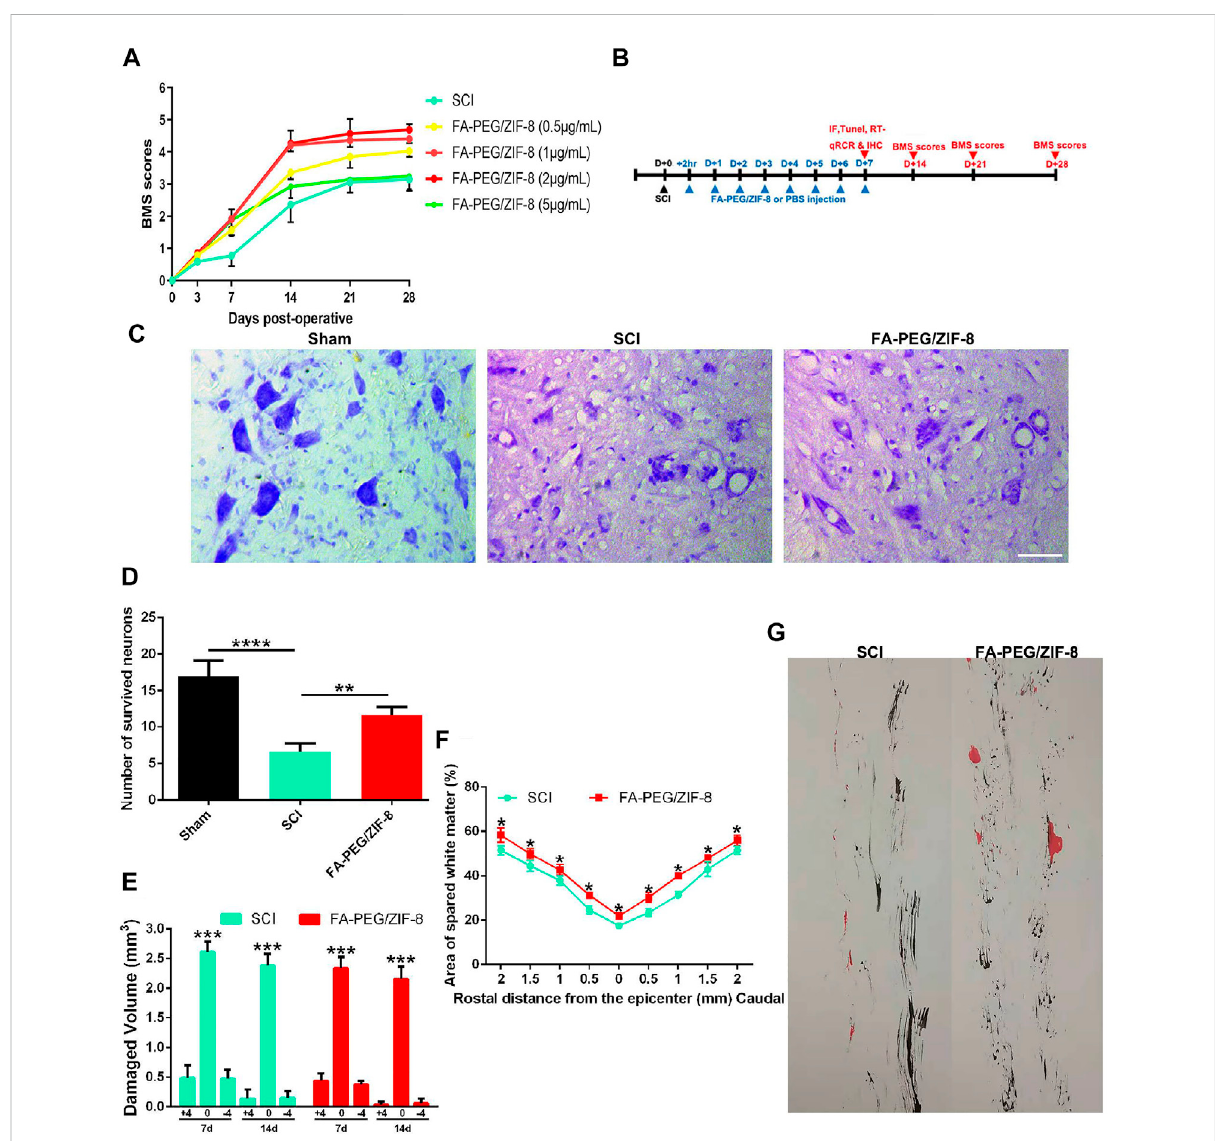
FIGURE 3 Therapeutic ef fi cacy of FA-PEG/ZIF-8 in SCI mice. Quanti fi cation analysis of BMS scores in the SCI mice treated with various concentrations of FA-PEG/ZIF-8. (A) Two-way ANOVA (repeated measures) with Bonferroni ’ s post-tests. The experimental time of this study. (B) Representative images (C) and quanti fi cation analysis (D) of neurons in the spinal cord. Quanti fi cation analysis of damaged volume (E) in SCI and FA-PEG/ZIF- 8groups7and14 dayspost-injury.Quanti fi cationanalysisofthelesionareapercentage (F) inmice.Two-wayANOVA(repeatedmeasures)with Bonferroni ’ s post-tests.Representative images of the giant experiment (G) in SCI and FA-PEG/ZIF-8 groups in 28 days post-injury. Scale bars, 100 µm. Data are presented as the mean±SD. Two-tailed Student ’ s t-test.* p < 0.1, ** p < 0.01, *** p < 0.001, **** p <